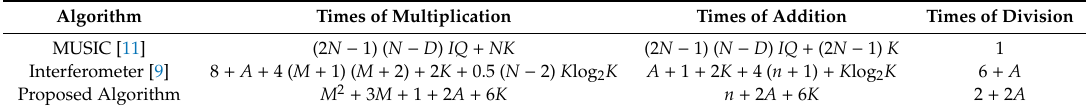
Table 1. The computational complexity of the algorithm. MUSIC: Multiple Signal Classification.